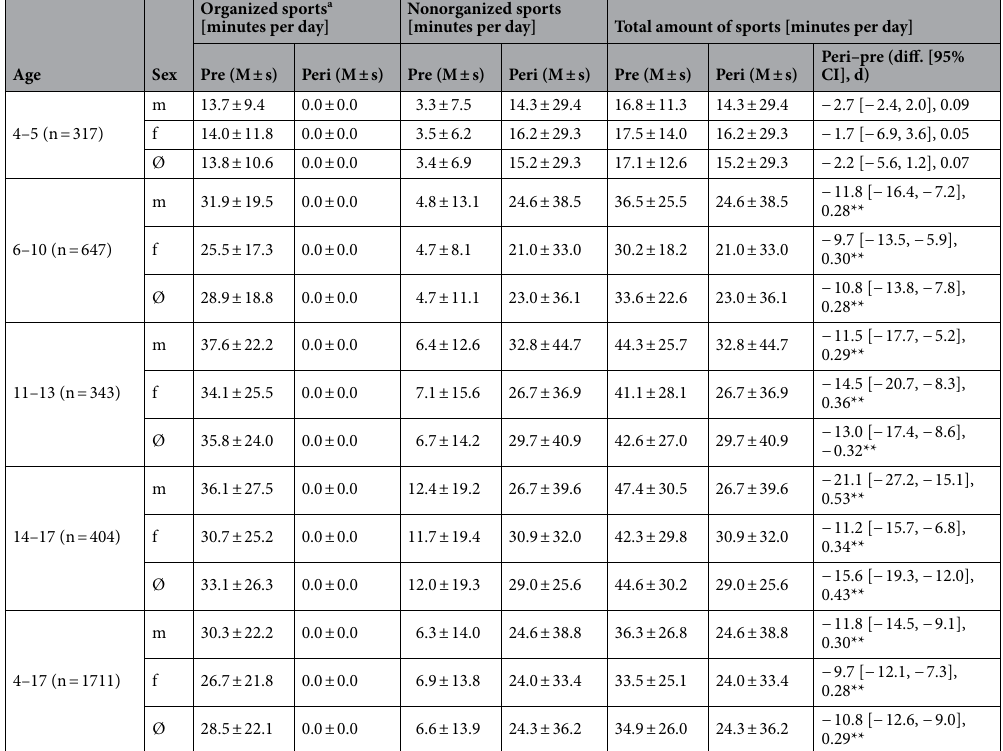
Table 2. Sports activity before and during the COVID-19 lockdown in Germany (MoMo Study). m male, f female, Ø mean of males and females, M mean, s standard deviation, 95% CI 95% confidence interval; d: